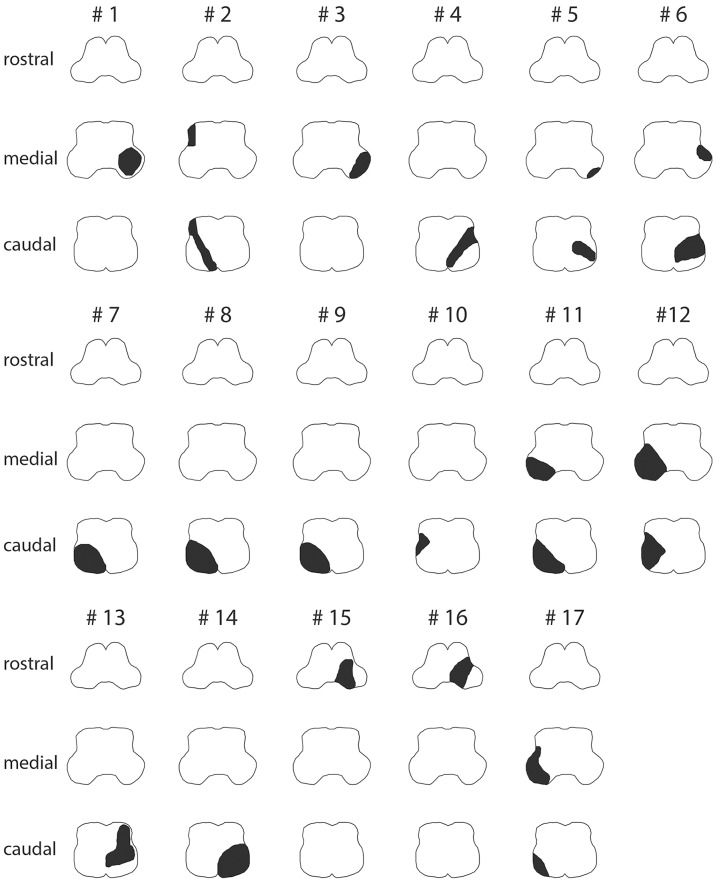
Graphical illustration of the extent of ischemic lesions (in black) at the caudal, middle, and rostral level of the medulla oblongata in all 17 patients as identified on MR imaging (see Figure S1 for corresponding MR-images).